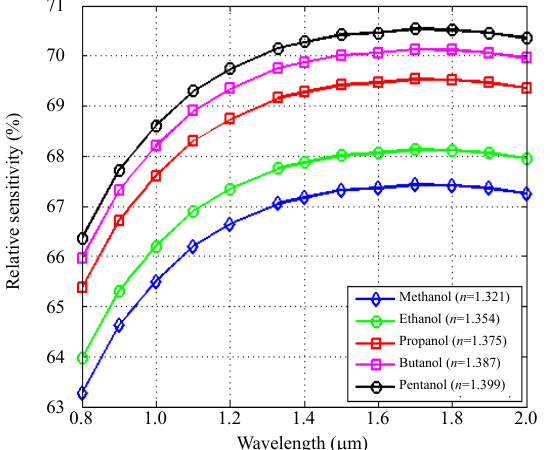
Fig. 4 Comparison of relative sensitivity with alcohol series for two-layer core.